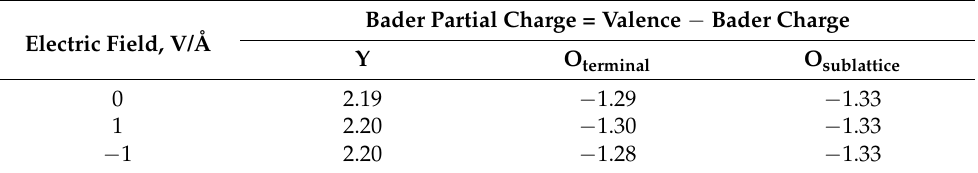
Table 2. Partial charge assignments of the Y-cation, the O terminal , and the O sublattice sites as calculated using the Bader charge approach for the three electric field cases: 0, +1, and − 1 V/Å.